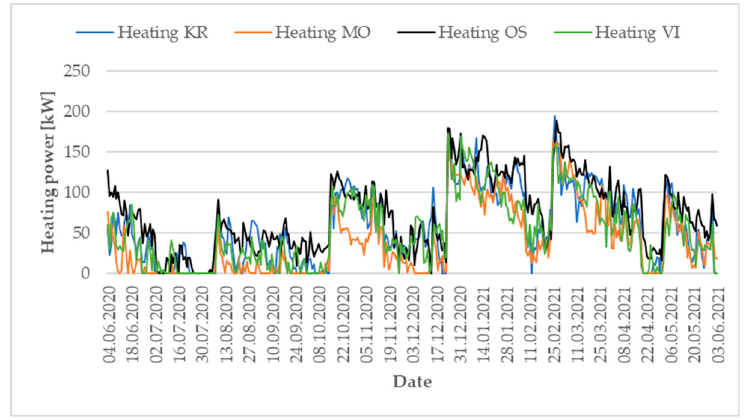
Figure 13. Heating power demand depending on building location, taking into account production cycles and technological breaks.